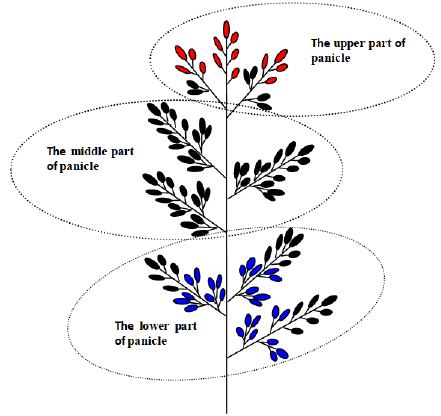
Figure 2. The rice panicle structure. The red, black, and blue grains represent the dominant grains (DG), middle grains (MG), and inferior grains (IG),